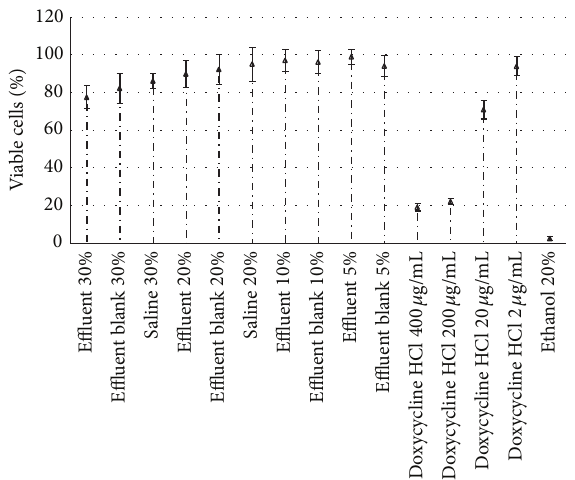
Figure 1: Results of cytotoxicity tests performed by adding the effluent from the Fenton process or doxycycline HCl to the culture medium after 24 h of incubation with L929 cells. Effluent blank did not contain the antibiotic. Ethanol 20% is considered to be responsible for 100% of cell death. Saline solutions are assumed to be inert for cells.